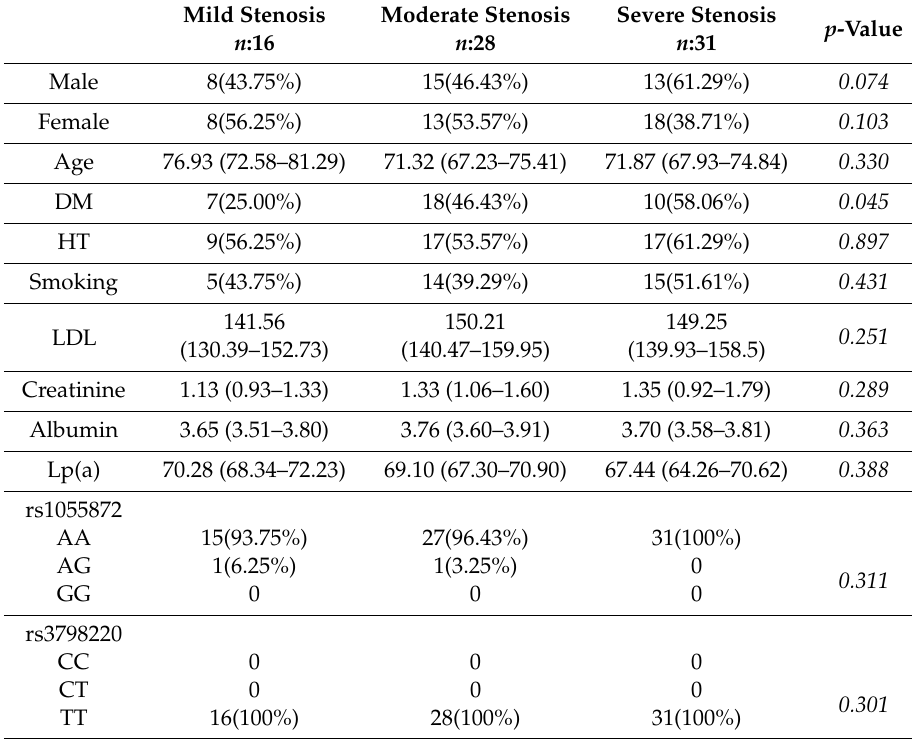
Table 3. Baseline characteristics and genotype of patient